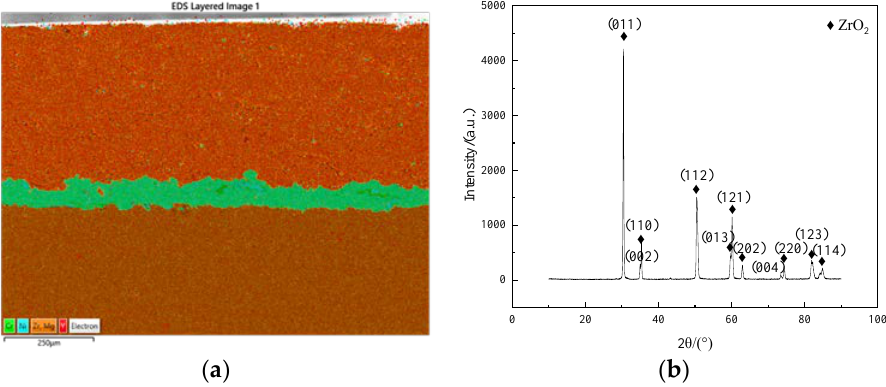
Figure 3. Morphology and XRD results of plasma spraying coating. ( a ) Morphology; ( b ) XRD results.